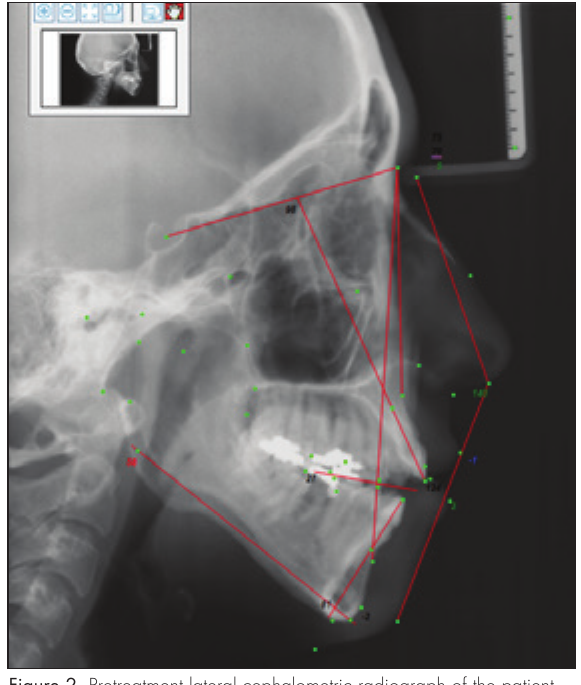
Figure 2. Pretreatment lateral cephalometric radiograph of the patient. Figure 3. Pretreatment posteroanterior radiograph of the patient.